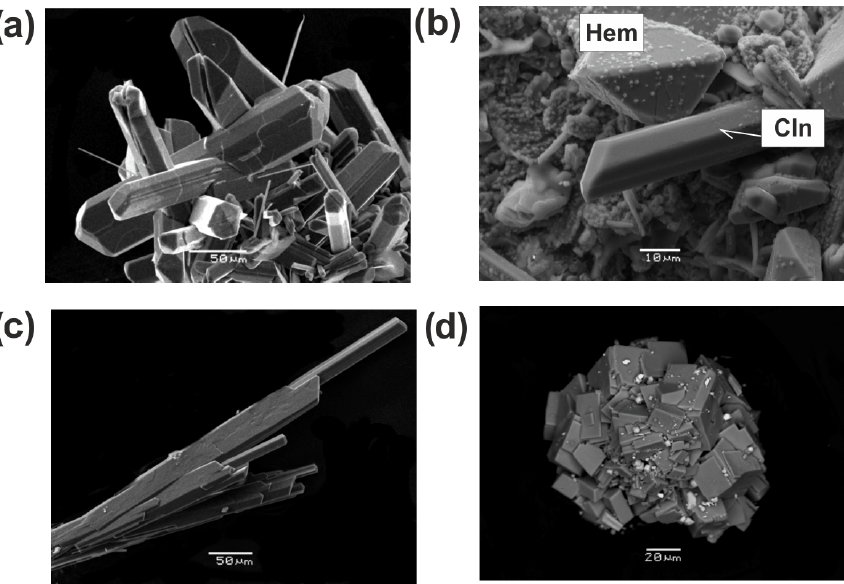
Figure 7. Pyroxenes from the Arsenatnaya fumarole: (a) aggregate of prismatic crystals of enstatite; (b) well-shaped prismatic crystals of clinoenstatite (Cln) in association with hematite (Hem); (c) sheaf-like cluster of long-prismatic crystals of aegirine (Aeg); (d) cluster of short-prismatic crystals of aegirine. SEM images: (a, c, b) SE images; (d) BSE